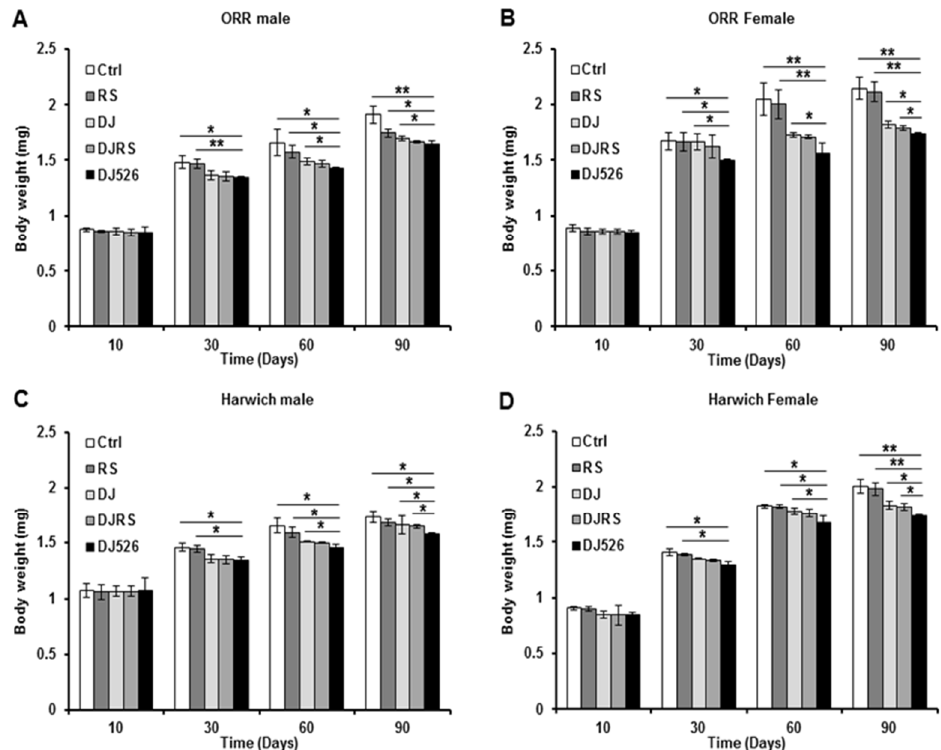
Figure 3. The e ff ects of the resveratrol rice DJ526 on changes in the body weights of D. melanogaster . ( A ) ORR males, ( B ) ORR females, ( C ) Harwich males and ( D ) Harwich females with age progression. Ctrl represents standard cornmeal medium; RS represents cornmeal medium supplemented with resveratrol at 31.54 µ g / L, the equivalent amount of resveratrol found in the DJ526 media; DJ represents the medium in which 50% of cornmeal was replaced with Dongjin rice; DJRS represents the medium in which 50% of cornmeal was replaced with Dongjin rice and supplemented with resveratrol at 31.54 µ g / L, and DJ526 represents the medium in which 50% of the cornmeal was replaced with the resveratrol rice DJ526 (Table S1). The body weights were measured at the 10th, 30th, 60th and 90th days post-eclosion. Statistical significance was analyzed with an unpaired Student’s t -test and indicated as * p < 0.05 and ** p < 0.01from 3 independent experiments (n = 30).